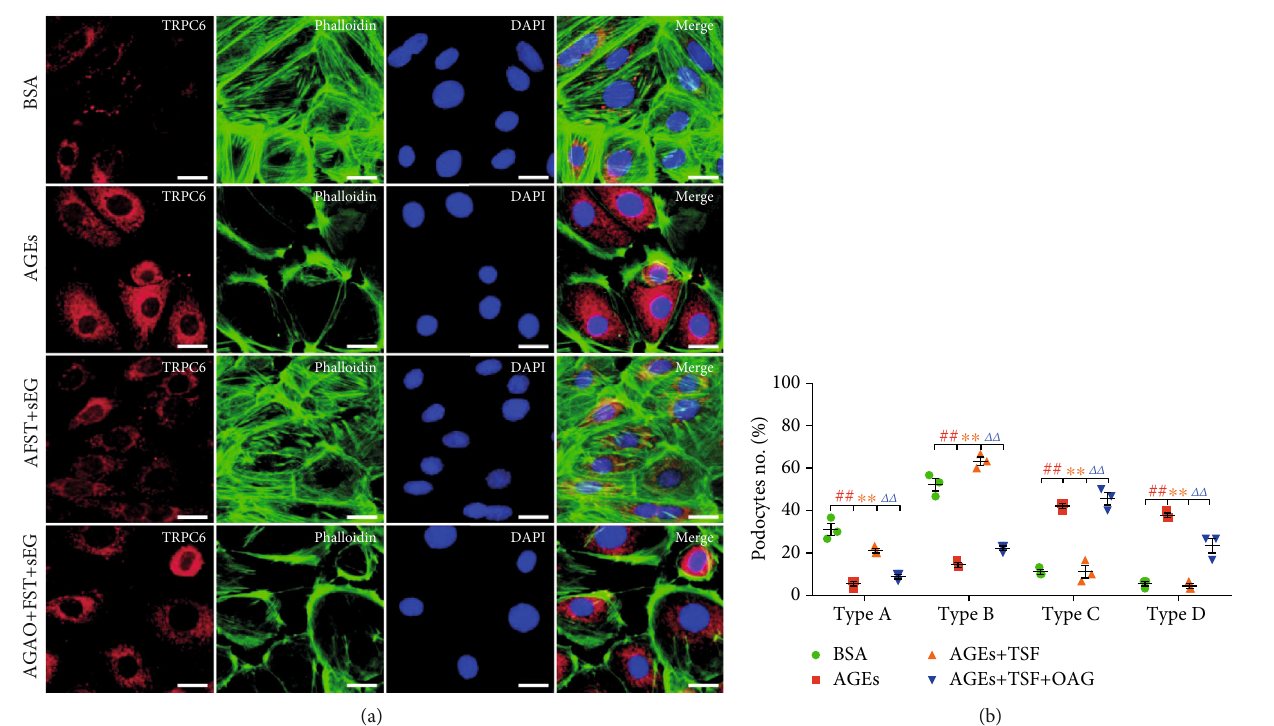
Figure 7: TSF alleviated TRPC6-dependent Ca 2+ accumulation-mediated actin-cytoskeletal disorganization in AGEs-stimulated primary mice podocytes. (a) Representative immuno fl uorescence stained with phalloidin and TRPC6 (scale bars, 25 μ m). (b) Quantitative analysis of the percentage of four types of phalloidin staining patterns in (a) by an observer blinded to the group (30 cells evaluated per experiment, n = 3 experiments). The data were expressed as the mean ± SEM of three independent experiments performed in triplicate. # P < 0 : 05 , ## P < 0 : 01 vs. BSA group; ∗ P < 0 : 05 , ∗∗ P < 0 : 01 vs. AGEs group; Δ P < 0 : 05 , ΔΔ P < 0.01 vs. AGEs + TSF group. Statistically analyzed via a one-way ANOVA with Dunnett ’ s